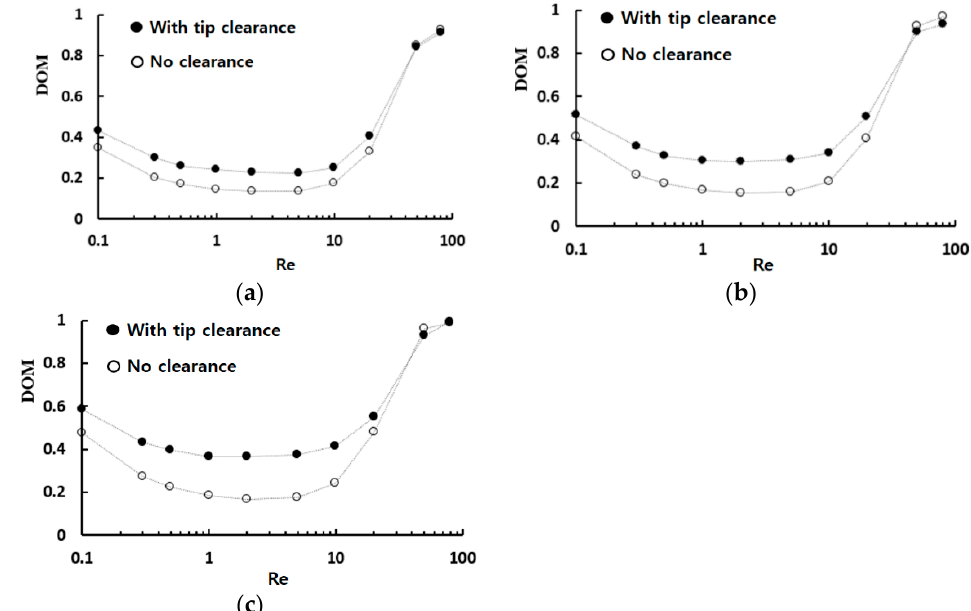
Figure 6. Enhancement of the DOM by tip clearance: ( a ) N = 3, ( b ) N = 4, and ( c ) N = 5.